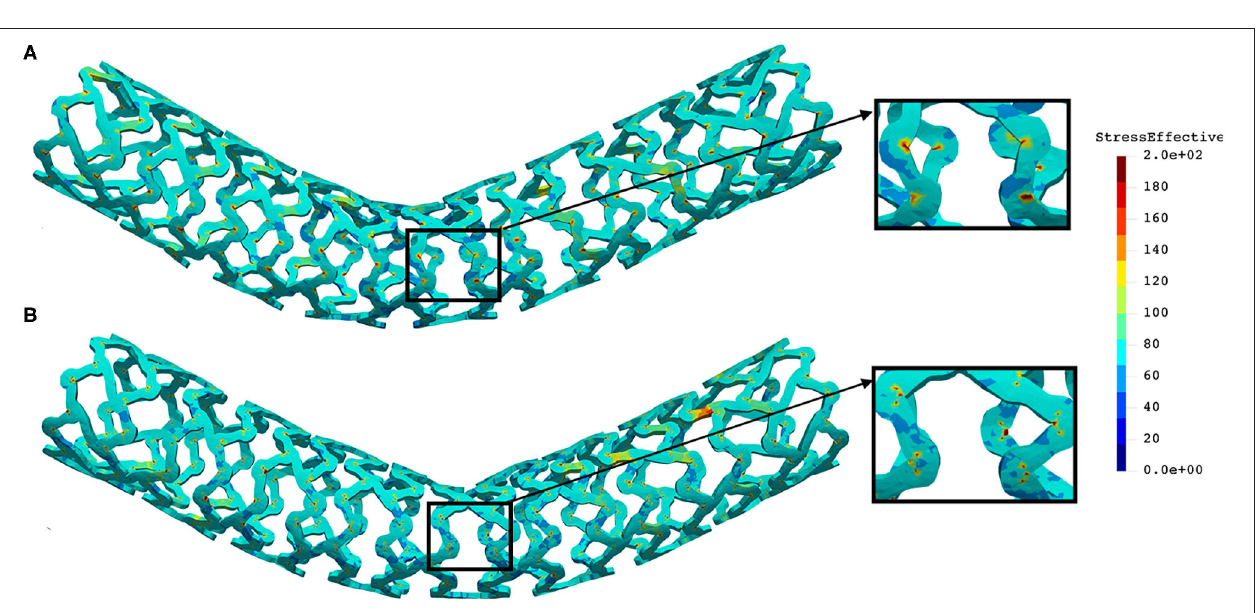
for the evaluation of mechanical characteristics of the